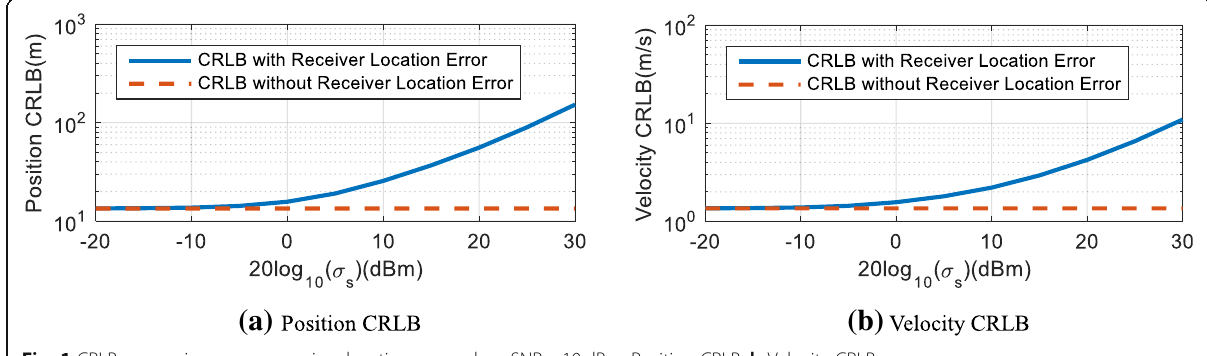
Fig. 1 CRLB comparison versus receiver location error when SNR = 10 dB. a Position CRLB. b Velocity